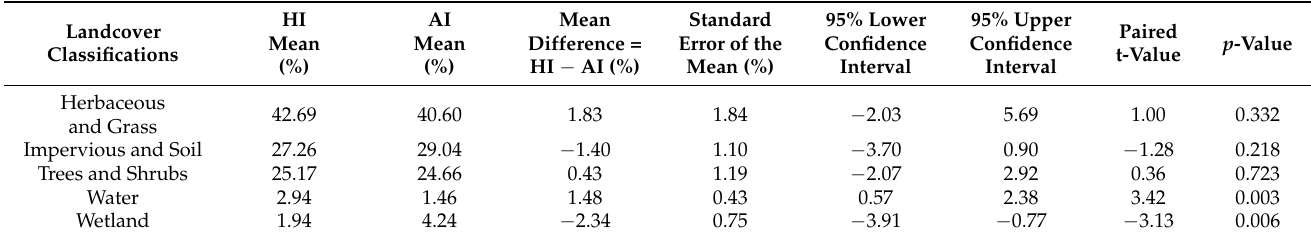
Table 1. Comparison of percent estimates of different landcover classes using human